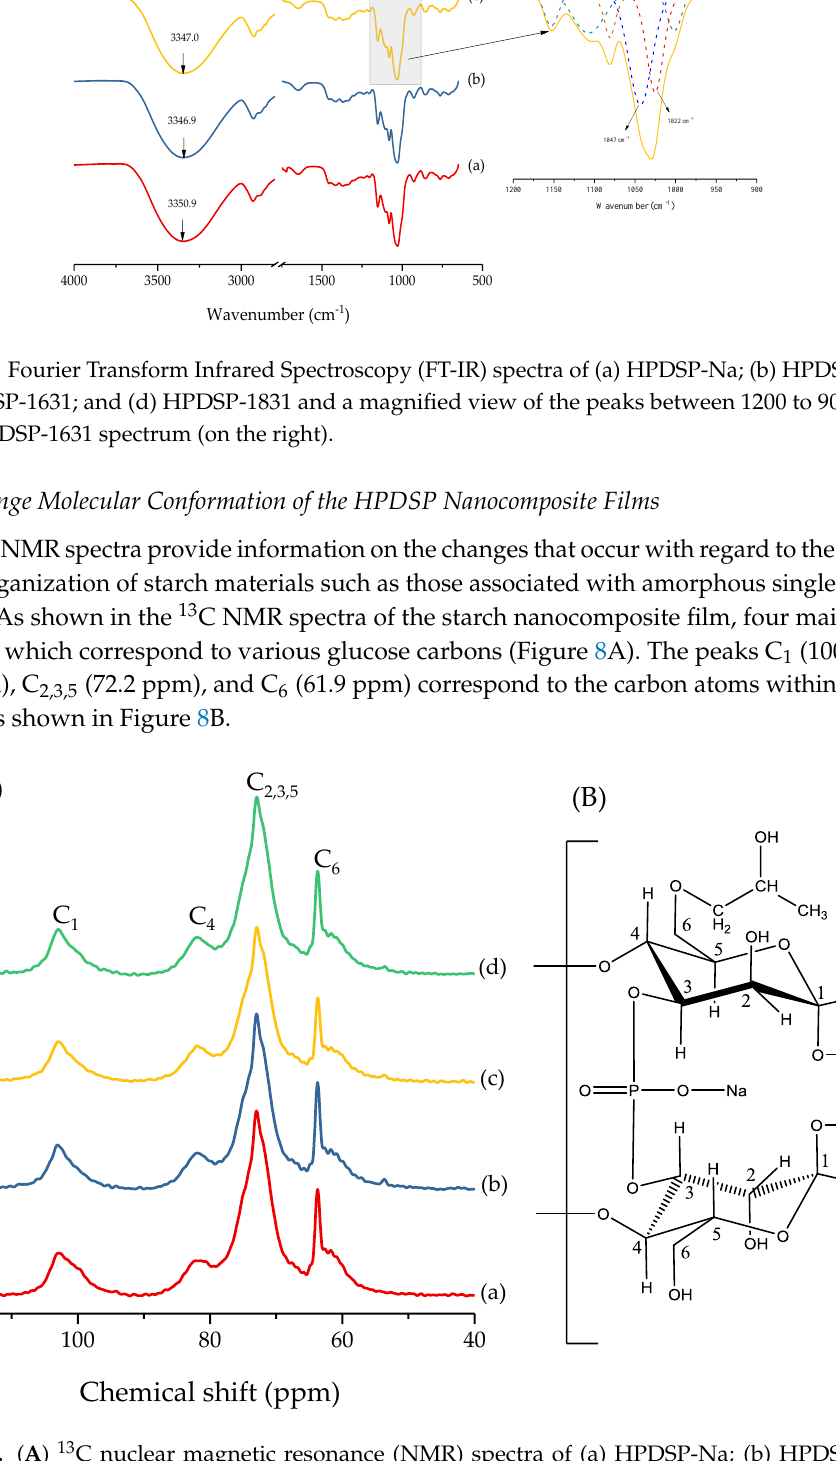
Figure 8. ( A ) 13 C nuclear magnetic resonance (NMR) spectra of (a) HPDSP-Na; (b) HPDSP-1231; (c) HPDSP-1631; (d) HPDSP-1831; and ( B ) the HPDSP structure.